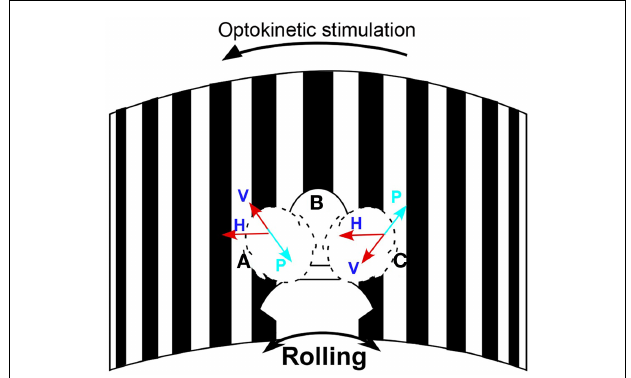
FIGURE 1 | Schematic diagram of the treatment paradigm .The subject’s head was passively rolled at her rocking frequency while watching the stripes moving to the left to act against the maladaptedVOR component to the right. H is the velocity of the horizontal optokinetic stimulus;V is the component of the optokinetic stimulus in the head sagittal plane; P represents the maladapted vertical component; Head positions: A, on the left, B, in the center, and C, on the right. Arrows show the direction of the horizontal and vertical slow phase